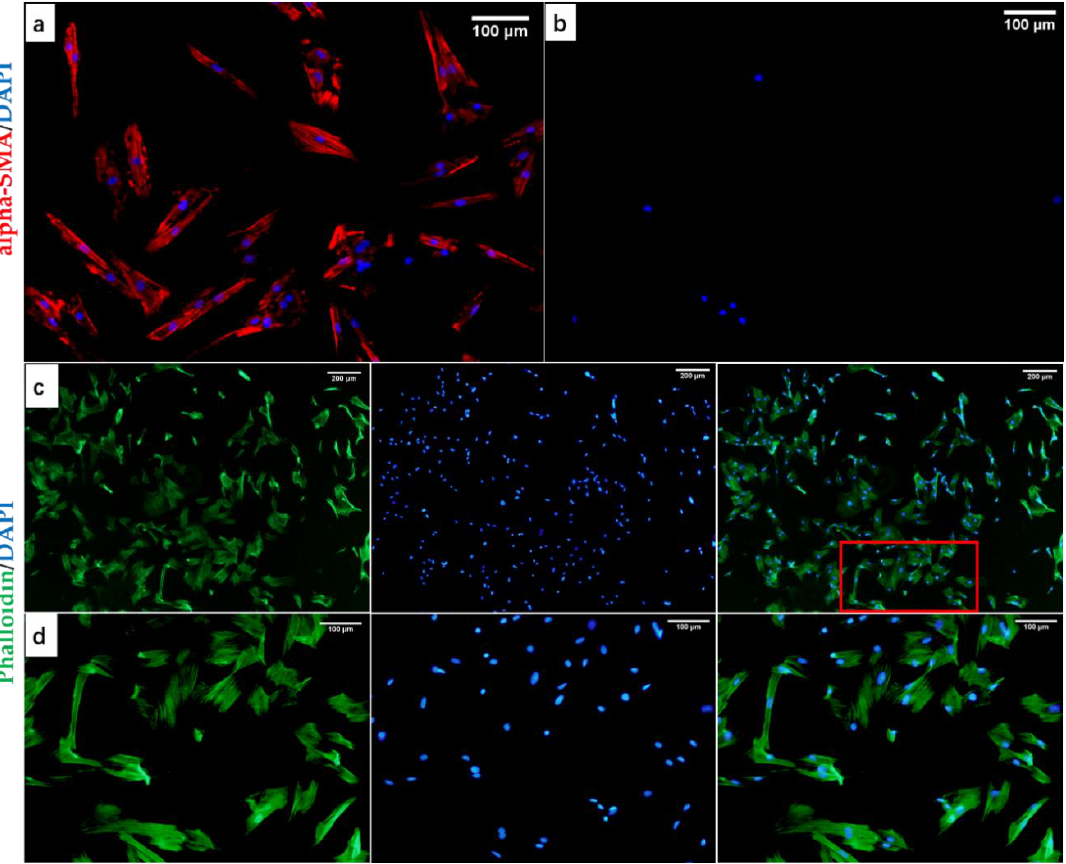
Figure 2. IF staining of dermal papilla cells (DPC) specific proteins and cell morphology. ( a ) Strong positive expression of alpha-SMA (red), ( b ) negative expression of CK-19 (only nuclei expression), ( c ) nuclei/cell microfilaments staining after 3-day of cell culture, including cell microfilaments (green), nuclei (blue), and their combination, ( d ) a partial view of ( c ). Scale bars, a, b and d = 100 μm, c = 200 μm.